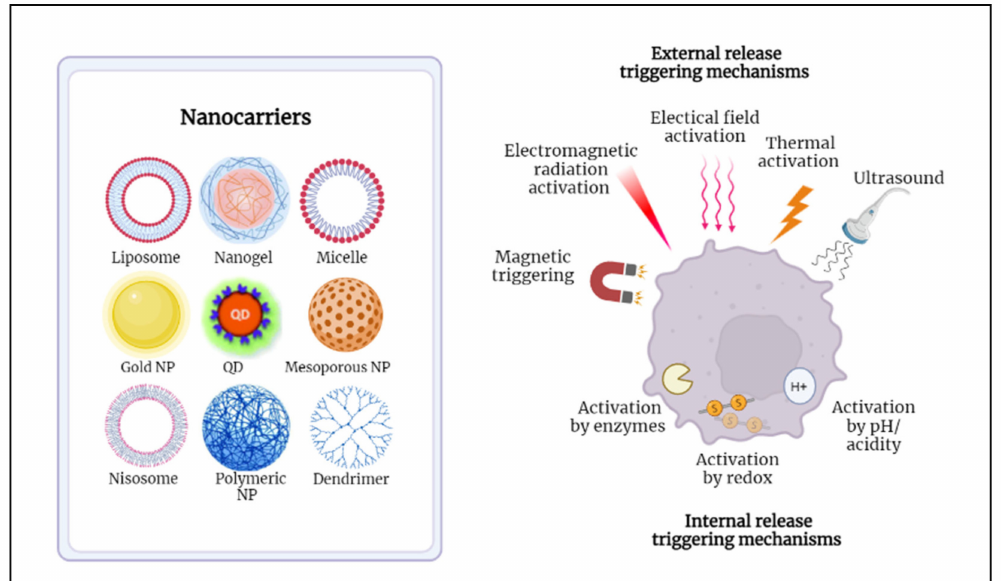
Figure 1. Presentation of the different nanocarriers and triggering mechanisms used in developing